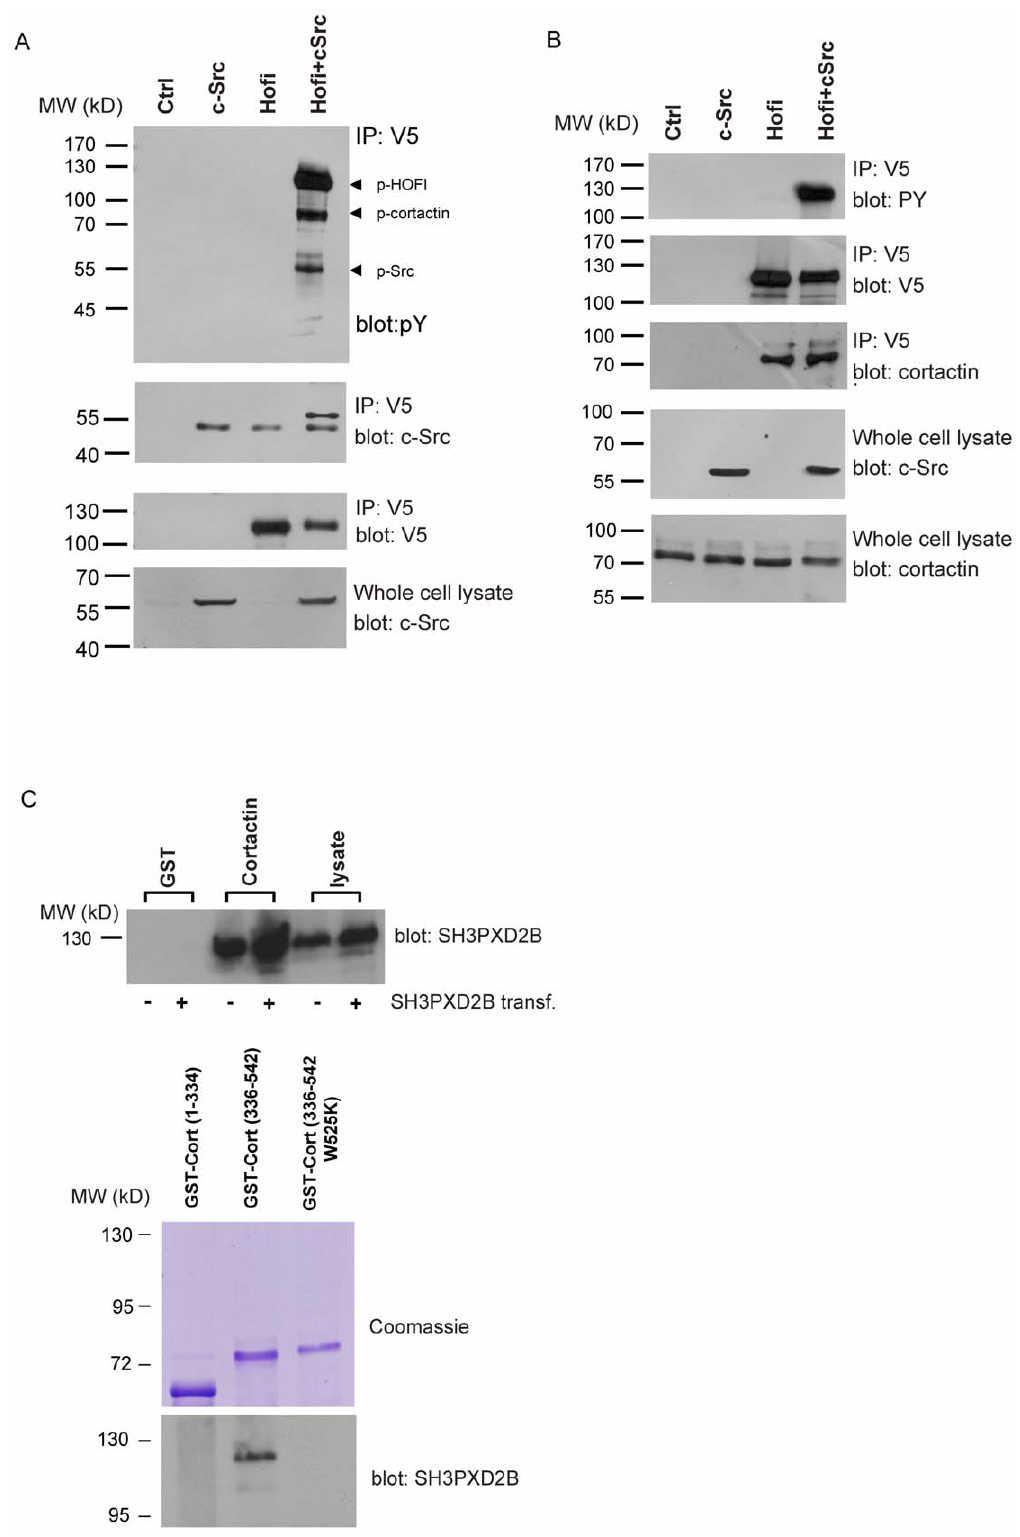
Figure 4. SH3PXD2B associates with Src and cortactin. ( A & B ) 293T cells were transfected with constructs expressing full-length SH3PXD2B carrying a C-terminal V5 epitope tag, Src or both. 48 hours past transfection cells were lysed and SH3PXD2B was precipitated using a V5-specific antibody. Immunoprecipitated proteins were blotted onto nitrocellulose membranes and detected with the indicated specific antibodies. The 52 kD- bands present in panel A. correspond to the heavy chain of the antibody used to precipitateV5-tagged SH3PXD2B. ( C ): In GST pull-down experiments recombinant GST or a GST-cortactin fusion protein were precipitated with glutathion-agarose beads from 293T cell extracts transfected ( + ) or not ( 2 )